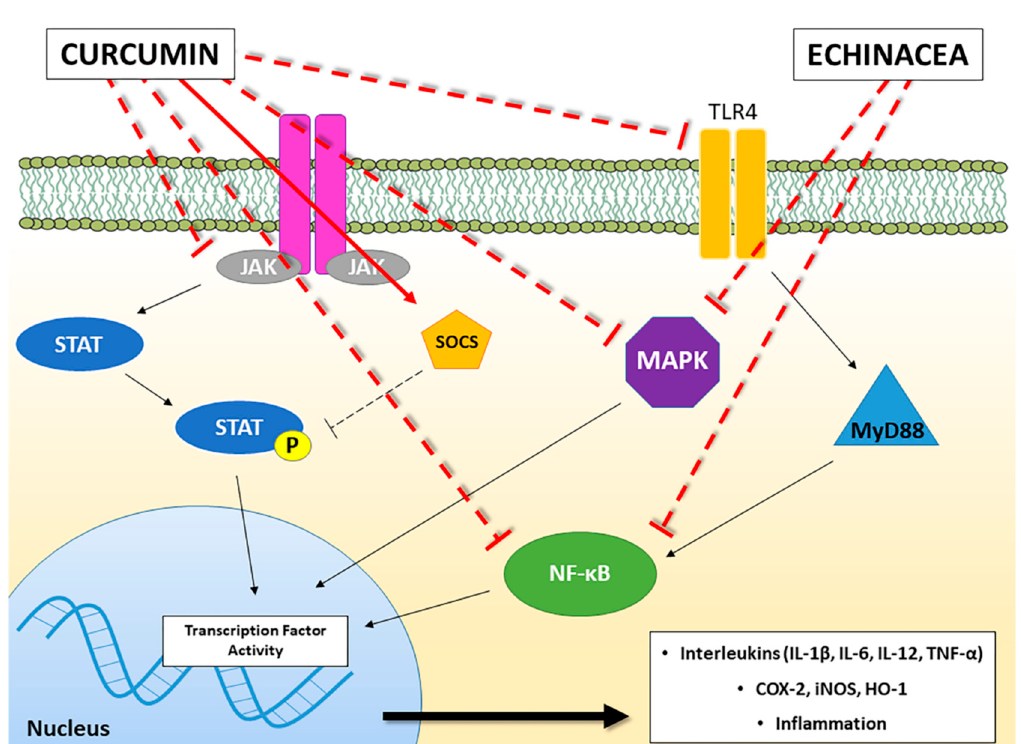
Figure 1. A schematic representation of the main molecular pathways linked to inflammatory and immunomodulatory activities modulated by Curcumin and Echinacea. The solid red line indicates the activation of the pathway, whereas the truncated red line indicates inhibition of the pathway. JAK: Janus kinase; STAT: Signal Transducers and Activators of Transcription; SOCS: Suppressor of Cytokine Signalling proteins; TLR ‐ 4: Toll ‐ like Receptor ‐ 4; MyD88: Myeloid Differentiation primary response 88; NF ‐κ B: Nuclear Factor kappa B; MAPK: Mitogen ‐ Activated Protein Kinase; COX ‐ 2: cyclooxygenase ‐ 2; iNOS: inducible Nitric Oxide Synthase; HO ‐ 1: Heme Oxygenase ‐ 1; IL: Interleukin; TNF: Tumor Necrosis Factor.